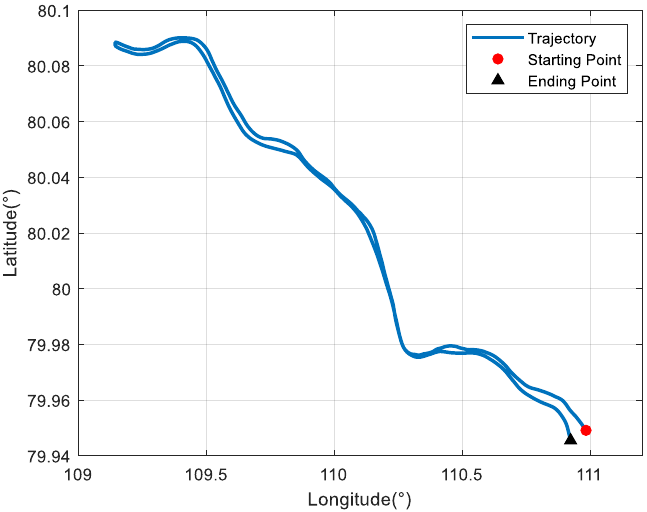
Figure 11. Ship trajectory at high latitudes.